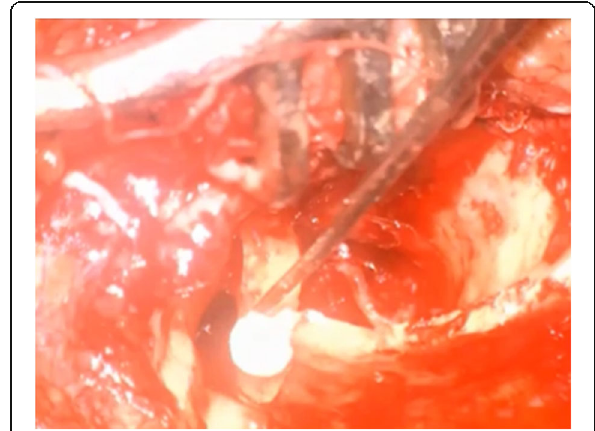
Fig. 2 Glass ionomer cement (GIC) used for stabilization of bone graft